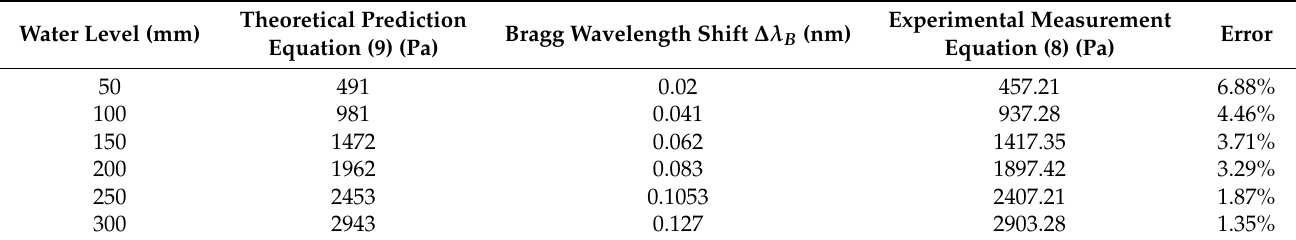
Table 3. Experimental measurement and theoretical prediction of hydrostatic pressure under various water levels with diaphragm thickness of 1.0